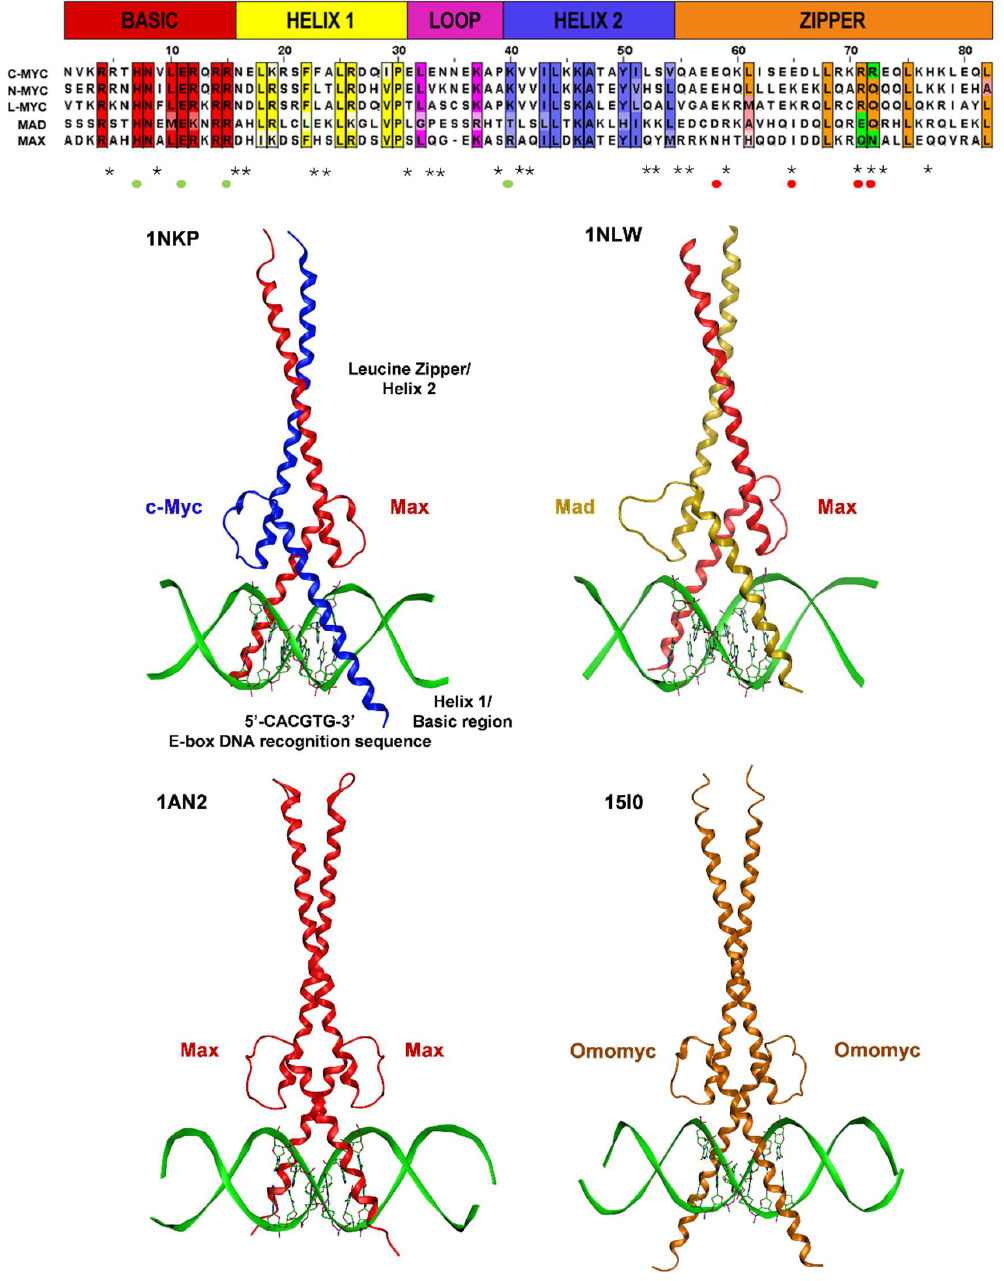
Figure 4. ( Top ) Multiple sequence alignment of the basic, helix-loop-helix, leucine zipper (bHLHLZ) domains of selected members of the Myc/Max/Mad network. Myc and Max monomers share ~60% similarity at the protein level in their bHLHLZ domains. Sequence conservations among Myc, Max, and Mad proteins are boxed and highlighted using the same coloring scheme as in the schematic of the bHLHLZ domain at the top. Conservation anomalies between the bHLHLZ domains of Max and Mad family relative to the three Myc paralogs [84] are indicated with a star (*) below the multiple alignment. Green dots indicate critical DNA recognition residues while red dots indicate important dimerization residues mutated in Omomyc. ( Bottom ) Available X-ray structures of complexes bound to the canonical E-box DNA recognition sequence: Myc-Max (PDB ID: 1NKP, 1.8 Å resolution), Mad-Max (PDB ID: 1NLW, 2 Å), Max-Max (PDB ID: 1AN2, 2.9 Å), and Omomyc (PDB ID: 15I0, 2.7 Å). Dimer assembly occurs through the helix-loop-helix (HLH) and leucine zipper (LZ) regions, while DNA binding takes place mainly through the basic (b) region and extends into the HLH